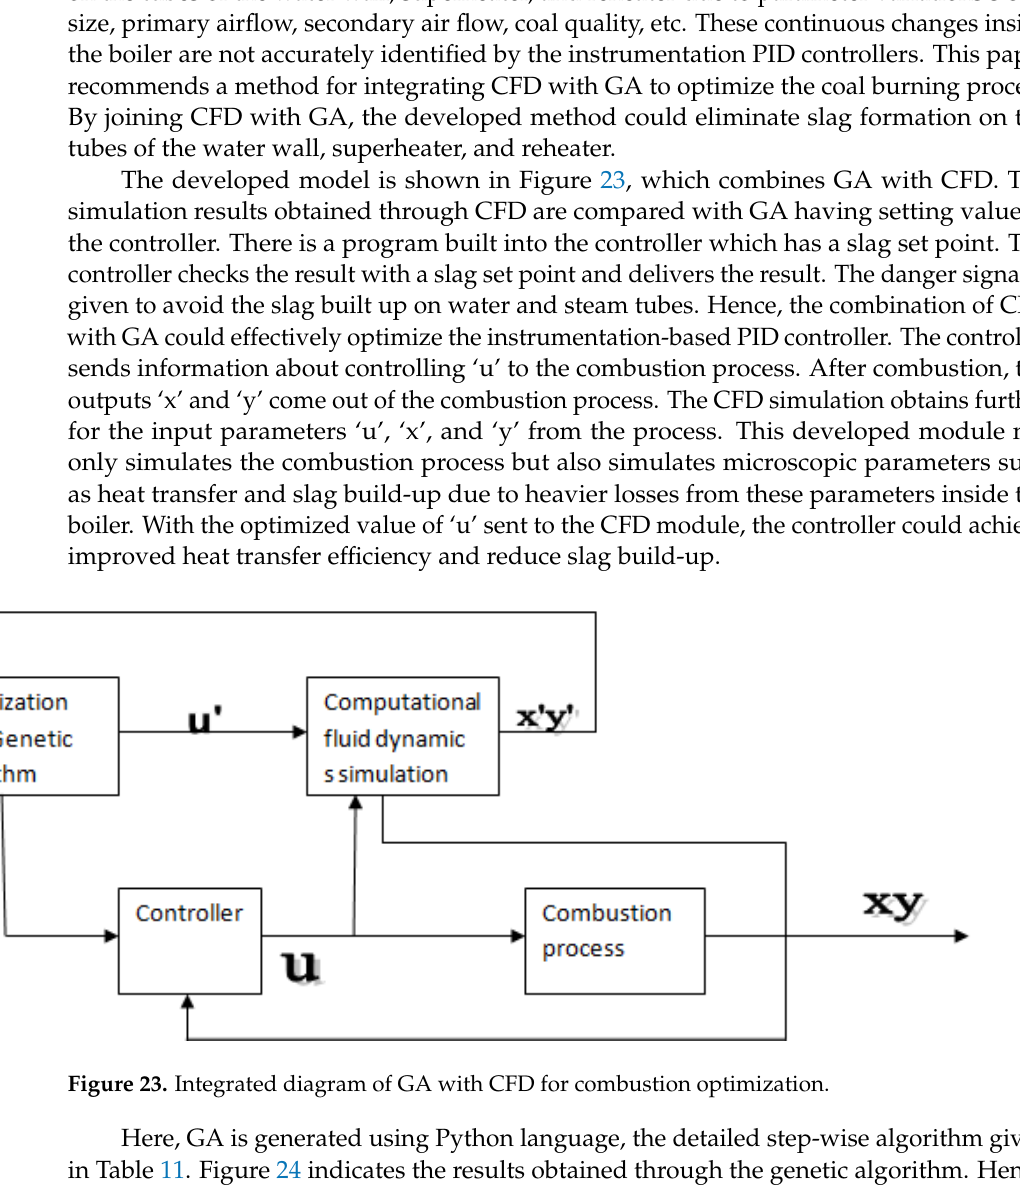
Figure 22. Different losses from the boiler for all cases.